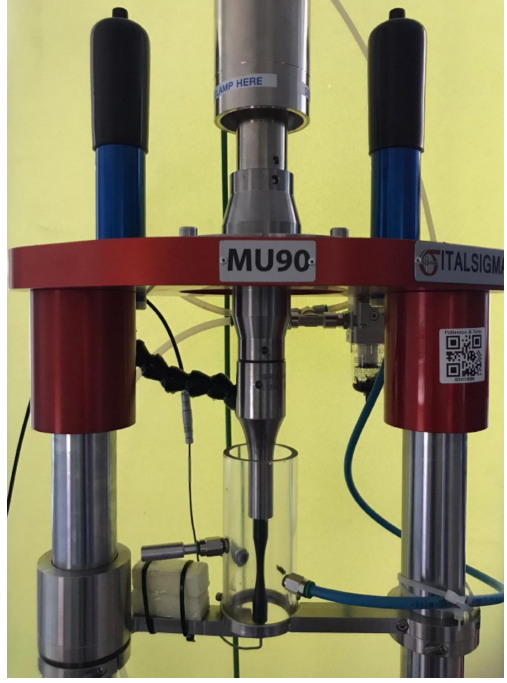
Figure 1. Ultrasonic fatigue testing machine